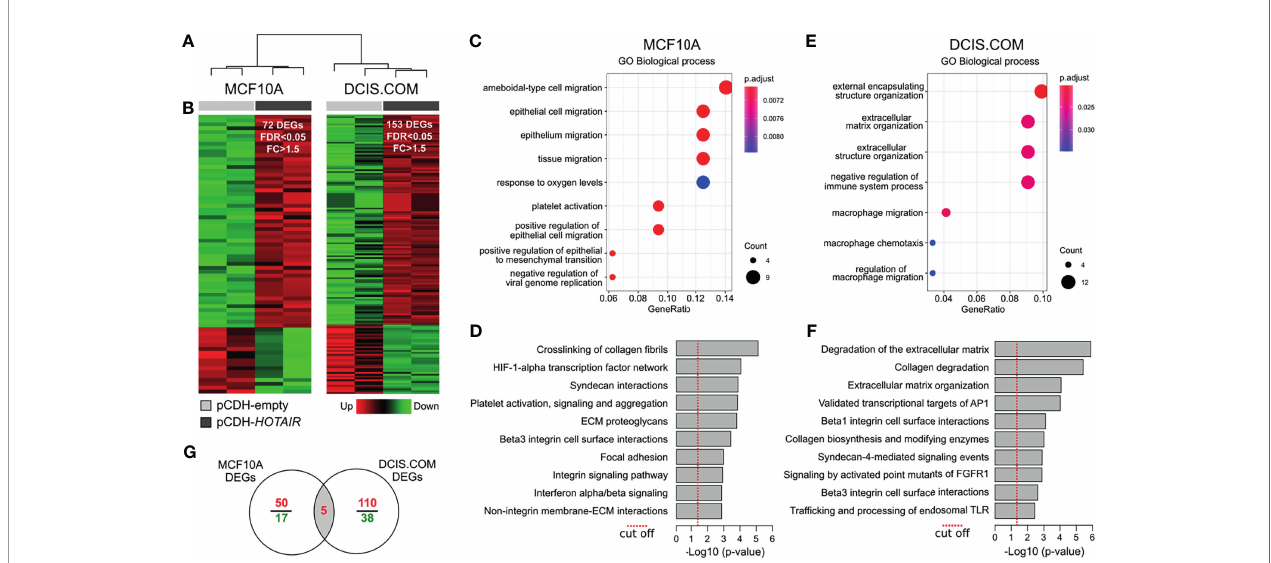
FIGURE 2 | Transcriptomic analysis of HOTAIR overexpressing cells. (A) Hierarchical clustering of MCF10A and DCIS.COM stably transduced cells with either vector control (pCDH-empty) or lentivirus expressing HOTAIR (pCDH- HOTAIR ) based on RNA-seq pro fi les. (B) Heat map representation of the differentially expressed genes (DEG) obtained by RNA-seq analysis (FDR<0.05; FC>1.5). Red represents upregulated genes and green downregulated genes. (C, D) Functional enrichment analysis of GO biological processes and pathways identi fi ed as affected by expression of HOTAIR in MCF10A cells. (E, F) Functional enrichment analysis of GO biological processes and pathways identi fi ed as affected by expression of HOTAIR in DCIS.COM cells. (G) Venn diagram of transcripts commonly modulated among MCF10 and DCIS.COM cells stably transduced with HOTAIR